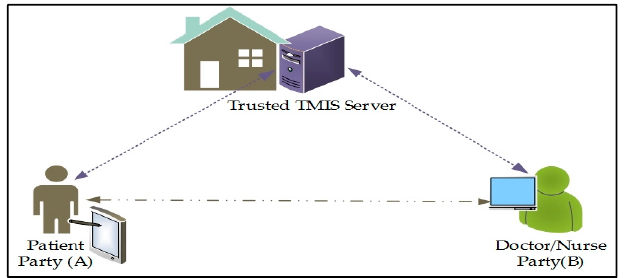
Figure 1. Telecare Medical Information System (TMIS) architecture.